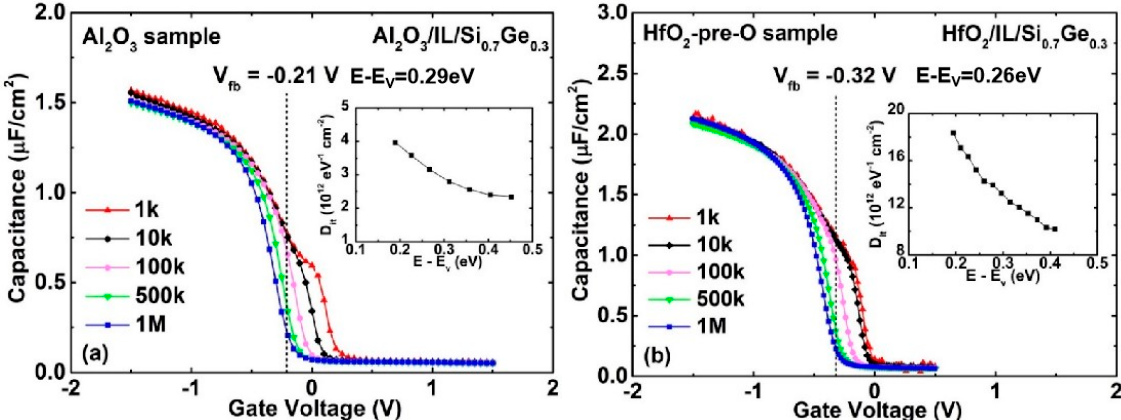
Figure 1. Multi ‐ frequency C ‐ V characteristics of ( a ) Al 2 O 3 sample ( b ) HfO 2 ‐ pre ‐ O sample with 30 min oxidation time (di ‐ Figure 1. Multi-frequency C-V characteristics of ( a ) Al 2 O 3 sample ( b ) HfO 2 -pre-O sample with 30 min oxidation time rect). The insets are their respective energy distributions of D it . (direct). The insets are their respective energy distributions of D it